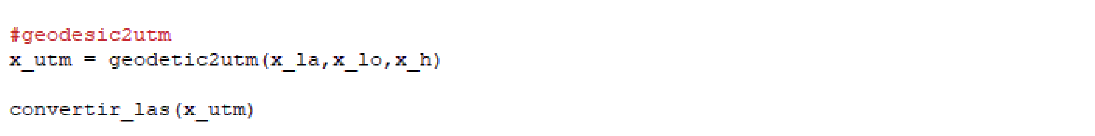
Figure 13. Point cloud georeferenced in the UAV reference system (x ″ , y ″ , z ″ ).